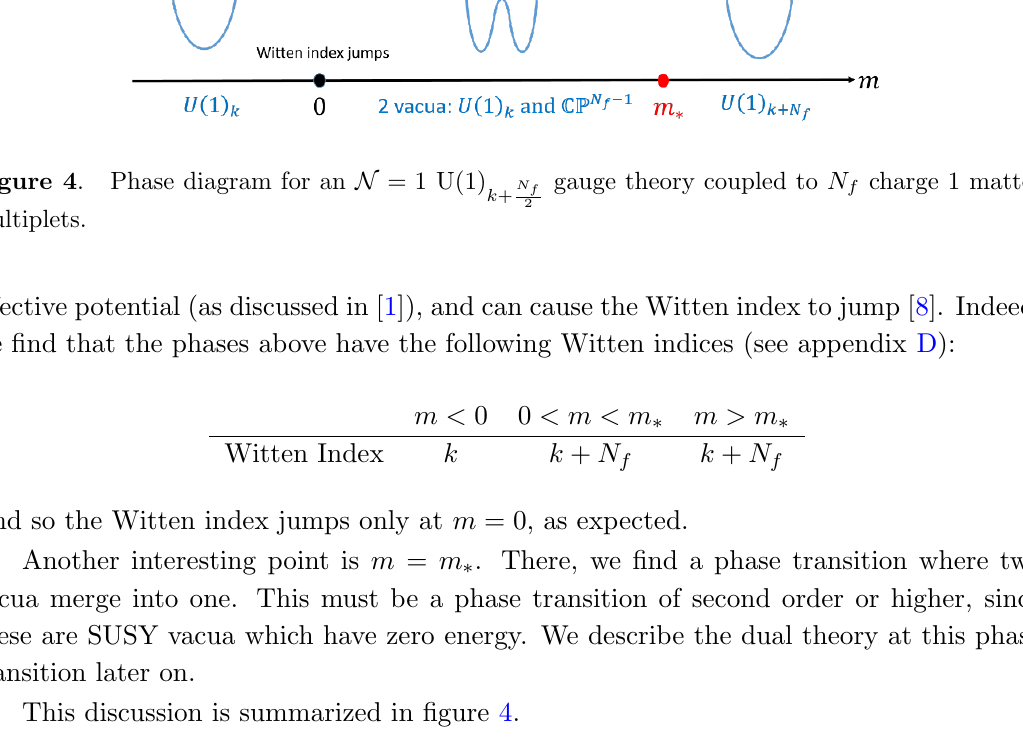
Figure 4 . Phase diagram for an N = 1 U(1)